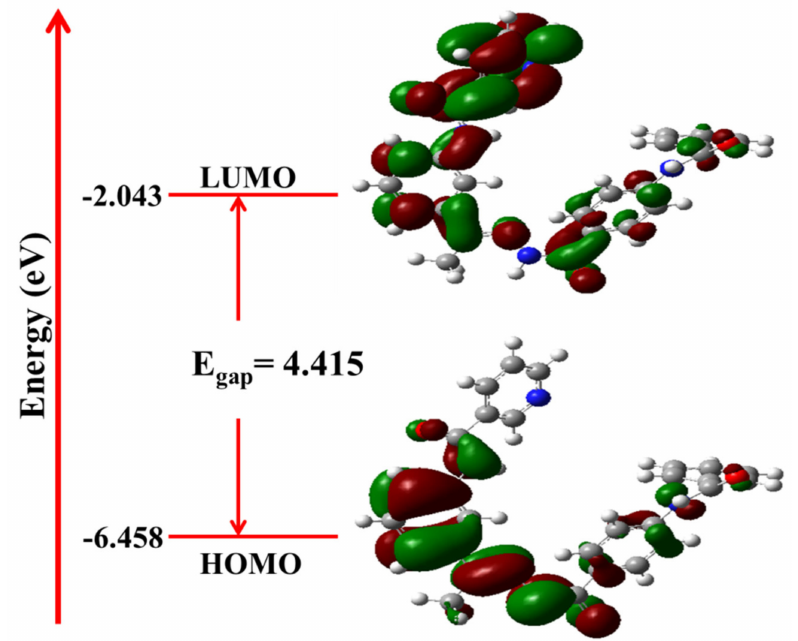
Figure 11. The frontier molecular orbitals; HOMO and LUMO at the ground state at B3LYB/6-